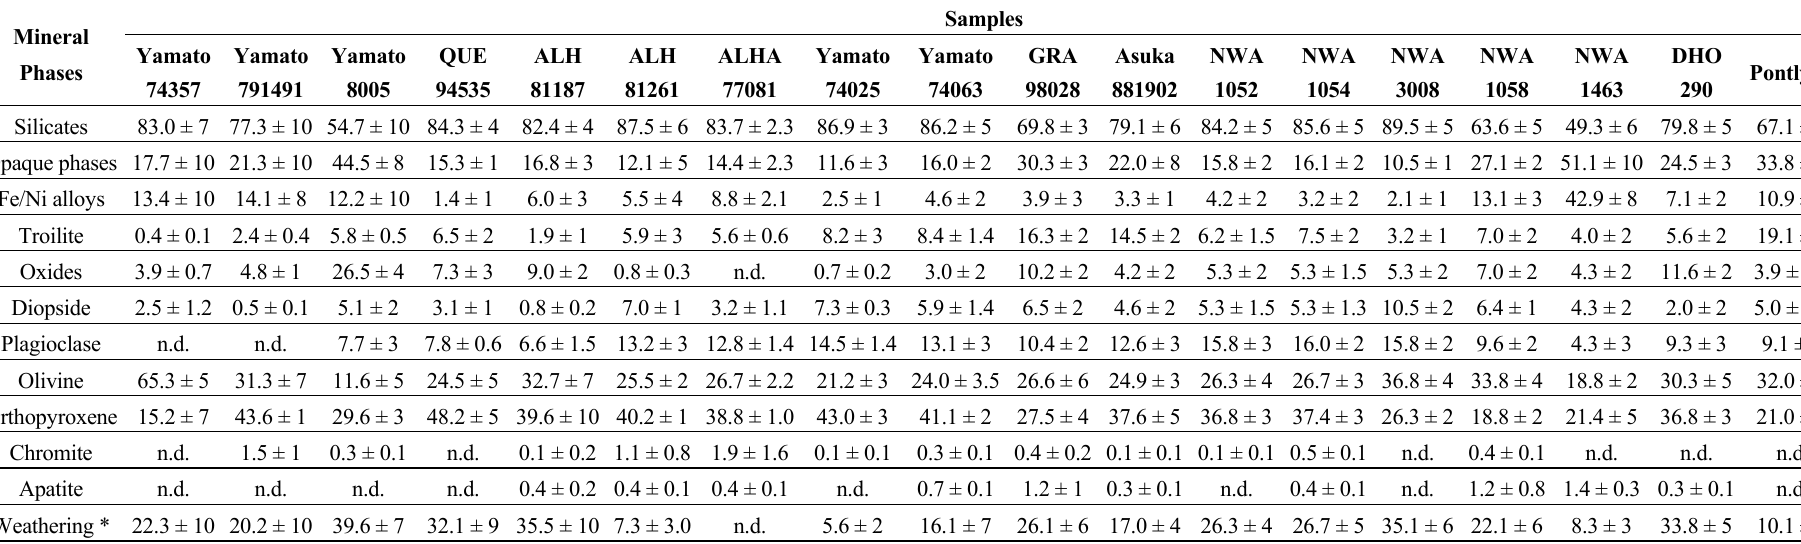
Table 3. Modal distribution of mineralogical phases as determined by analysis of X-ray map images; all values are in %; error is 2 σ ; sample classification is reported in Table